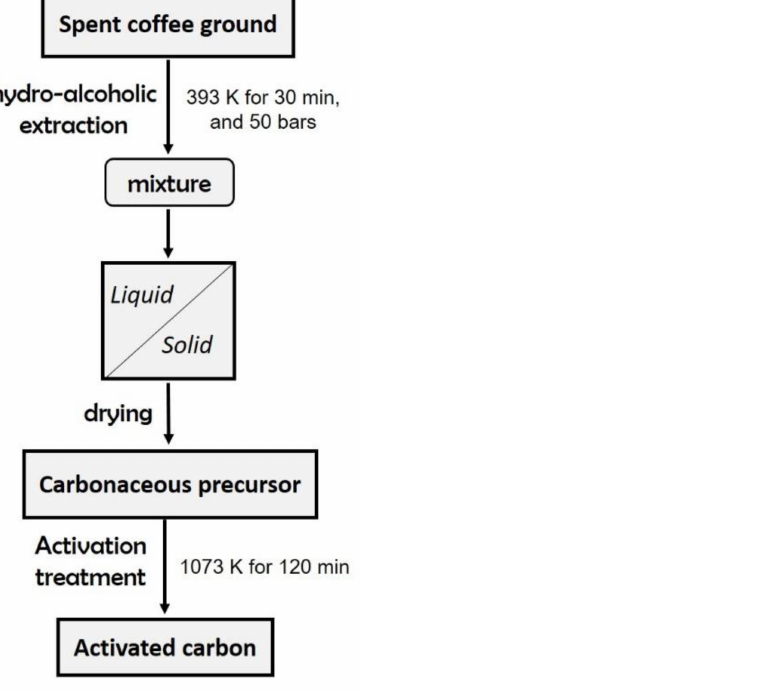
Figure 1. Schematic procedure to yield the corresponding activated carbon